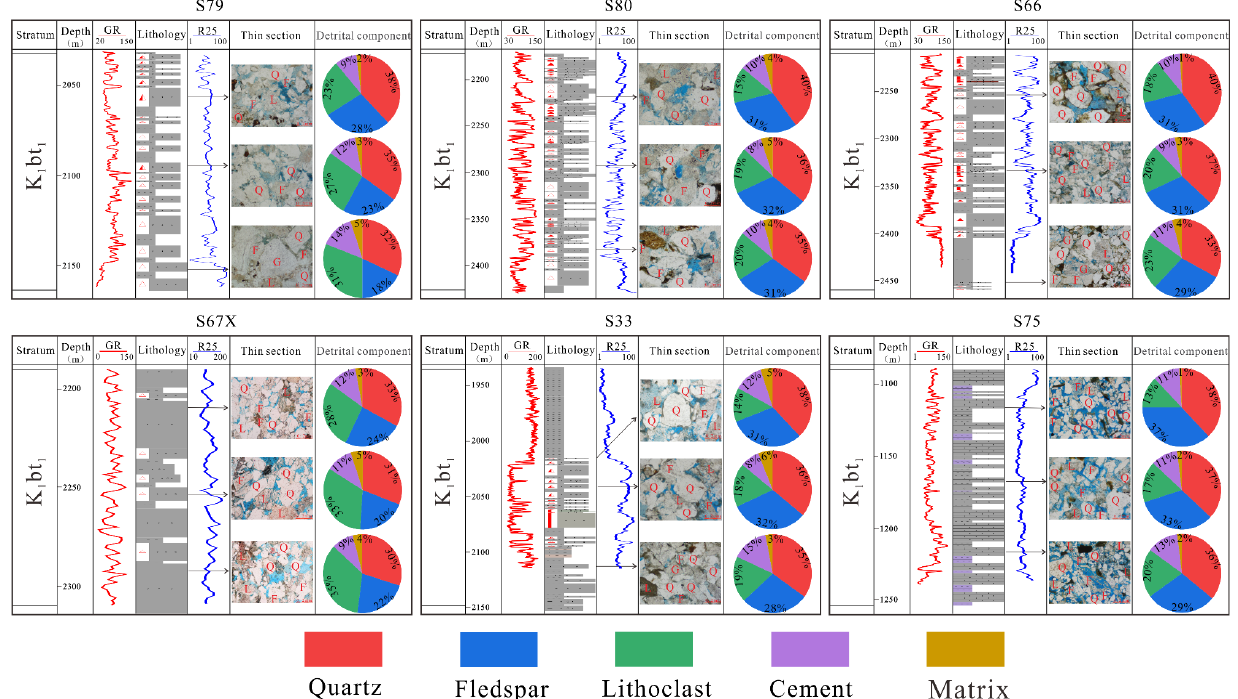
Figure 6. Characteristics of debrital components in member 1 of the Tengge’er Formation in Saidong sub-sag, Saihantala sag. Abbreviations: Q: Quartz; F: Feldspar; L: Lithoclast; G: Granite.